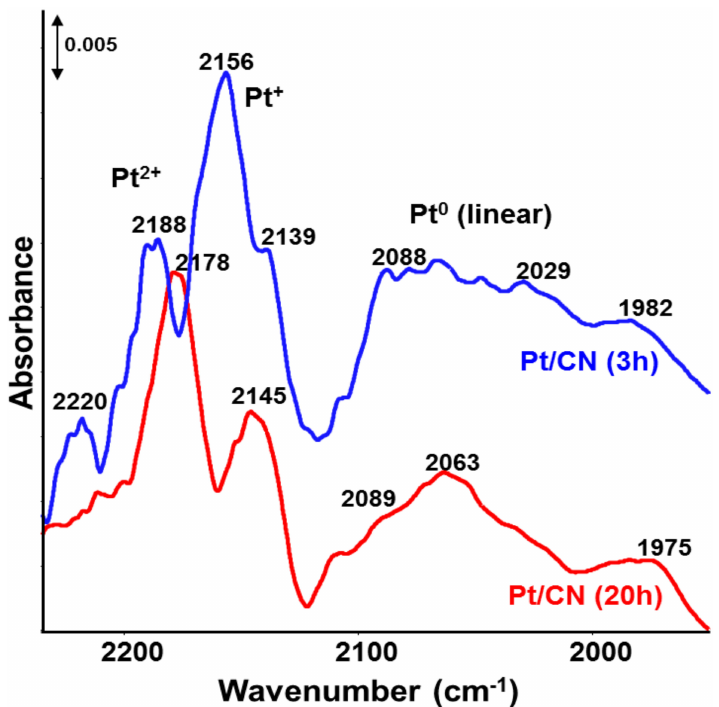
Figure 4. FTIR spectra of adsorbed CO for catalyst Pt/CN after 3 h and 20 h use in the reaction with UV-vis